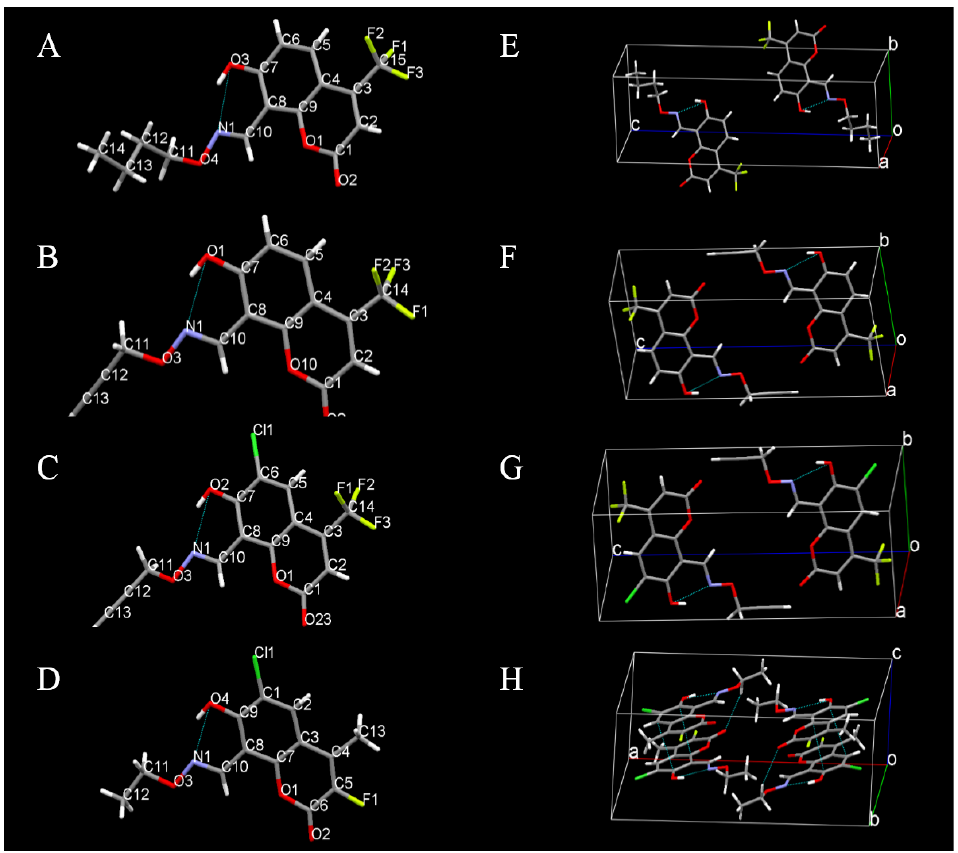
Figure 3. ( A – D ) The crystal structural diagram of 4e , 4h , 5h and 6c . ( E – H ) The corresponding crystal packing diagram of 4e , 4h , 5h and 6c . Table 1. Crystal data of title compound 6c .